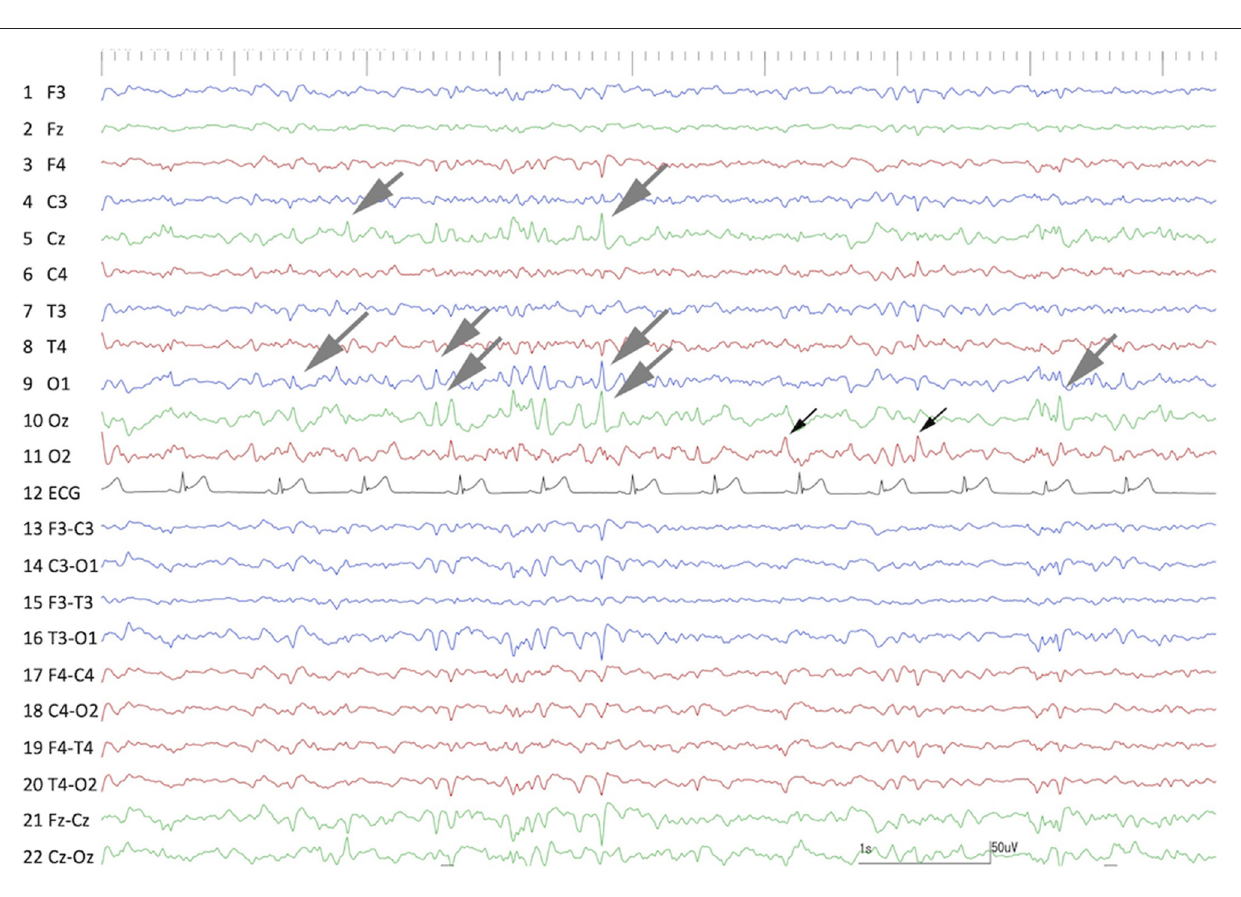
FIGURE 9 | Interictal scalp EEG at 60 days after the 2nd surgery (hippocampectomy). Frequent spikes and polyspikes were observed at O1, Oz, and Cz (gray arrows). Less frequent spikes were still observed at the operated region (O2) (black arrows). Compare to Figure 1